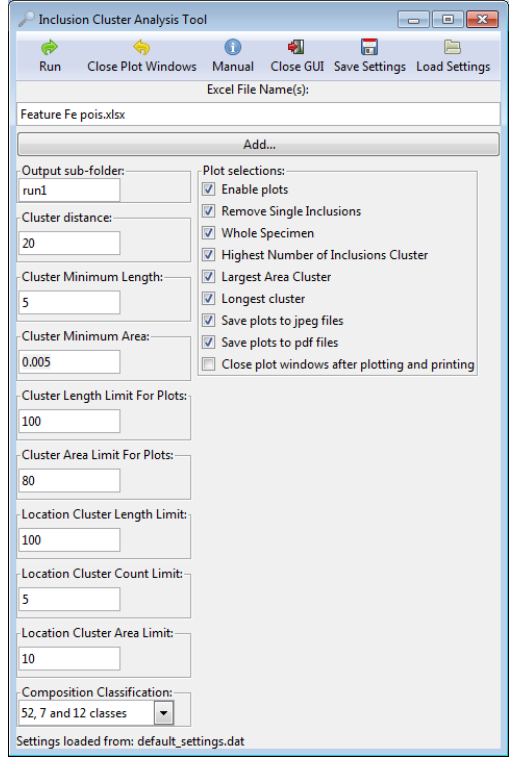
Figure 4: Main window of the tool’s graphical user